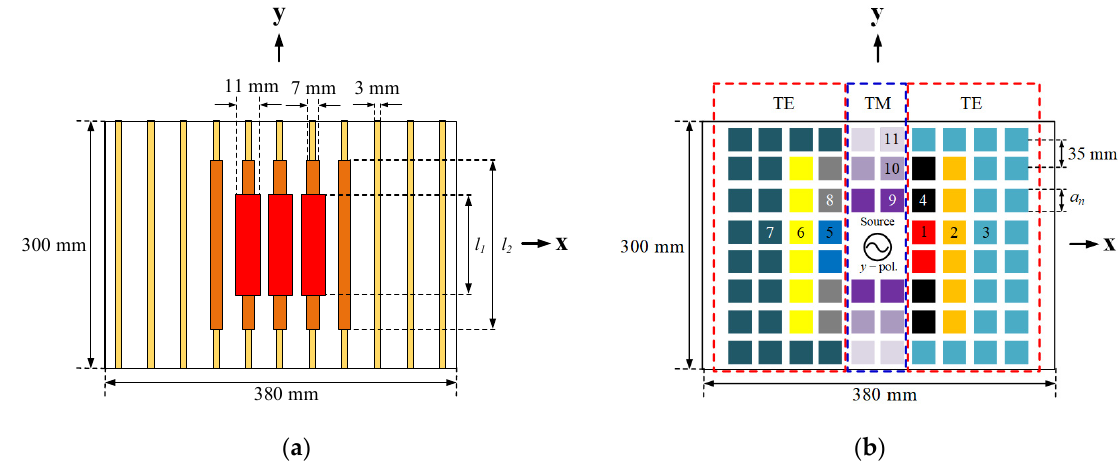
Figure 4. Deployment of ( a ) the tapered PRS superstrate and ( b ) the AMC ground plane. The design parameters of the PRS are l 1 = 105 mm and l 2 = 175 mm. Each length of the AMC cell a n is determined for a scanned beam in the target direction θ t = 30°, and is listed in Table 1.